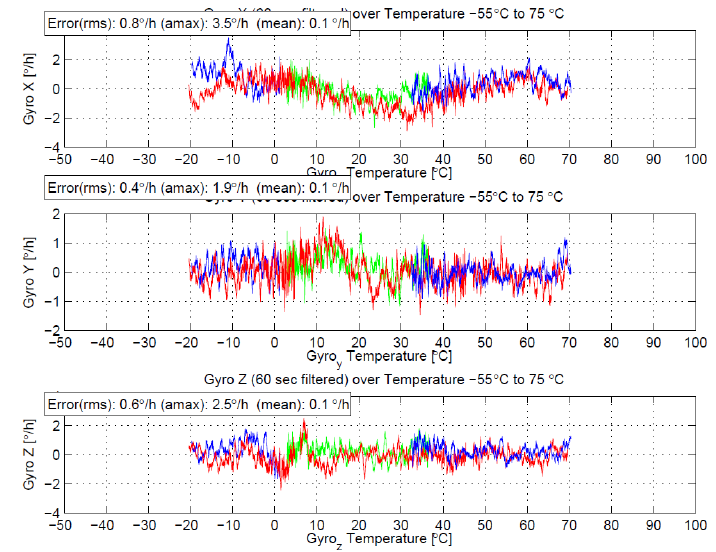
Figure 5. MEMS gyroscopes temperature-cycled and evaluated in our MEMS-IMU SN1880 as a test vehicle and evaluated in the temperature range from −20 °C to +70 °C ambient. Temperature was stabilized at −15, −54, −10, +30, +75, and +10 °C for 2 h, with intermediate ramps of 1 K/min. The three subgraphs show 60 s median filtered rotation rate data in [°/h] over temperature in [°C] for the three gyro axes X, Y, and Z respectively. The three temperatures were measured locally at each gyro. The 1σ bias errors over temperature of the three gyroscopes are 0.8, 0.4, and 0.6°/h respectively.